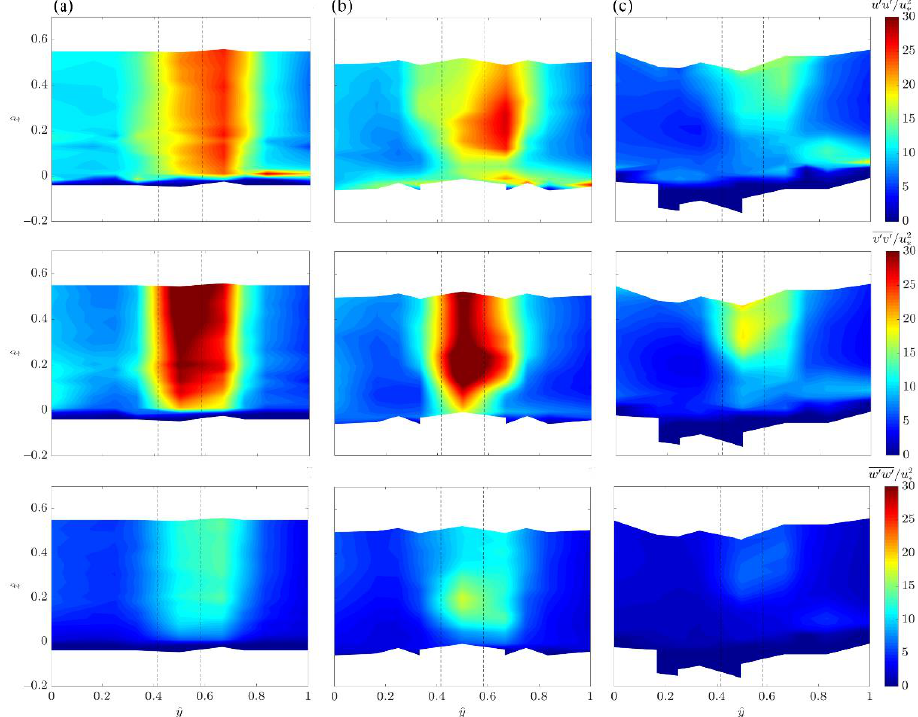
Figure 11. Contours of the dimensionless normal stresses (a) 𝑢 ′ 𝑢 ′ ̅̅̅̅̅̅/𝑢 ∗2 , (b) 𝑣 ′ 𝑣 ′ ̅̅̅̅̅̅/𝑢 ∗2 and (c) 𝑤 ′ 𝑤 ′ ̅̅̅̅̅̅̅/𝑢 ∗2 in the downstream plane section (from LV to RV) for ( a ) Run 1, ( b ) Run 2 and ( c ) Run 3. The black dashed lines show the cylinder position. The distributions of the dimensionless TKE in the longitudinal extreme right vertical plane (identified with letters from RE to RV) are illustrated in Figure 12. High TKE mag- nitudes are observed in the near-bed flow zone, where the bed roughness surface causes higher fluctuations of the velocity components. However, the TKE reduces progressively moving upwards from z > 0, owing to the inhibition of u’ , v’ , and w’ . The TKE contours are slightly spatially nonuniform for all the experiments. This is probably due to the ran- dom vegetation array and the spatial irregular bed sediment.